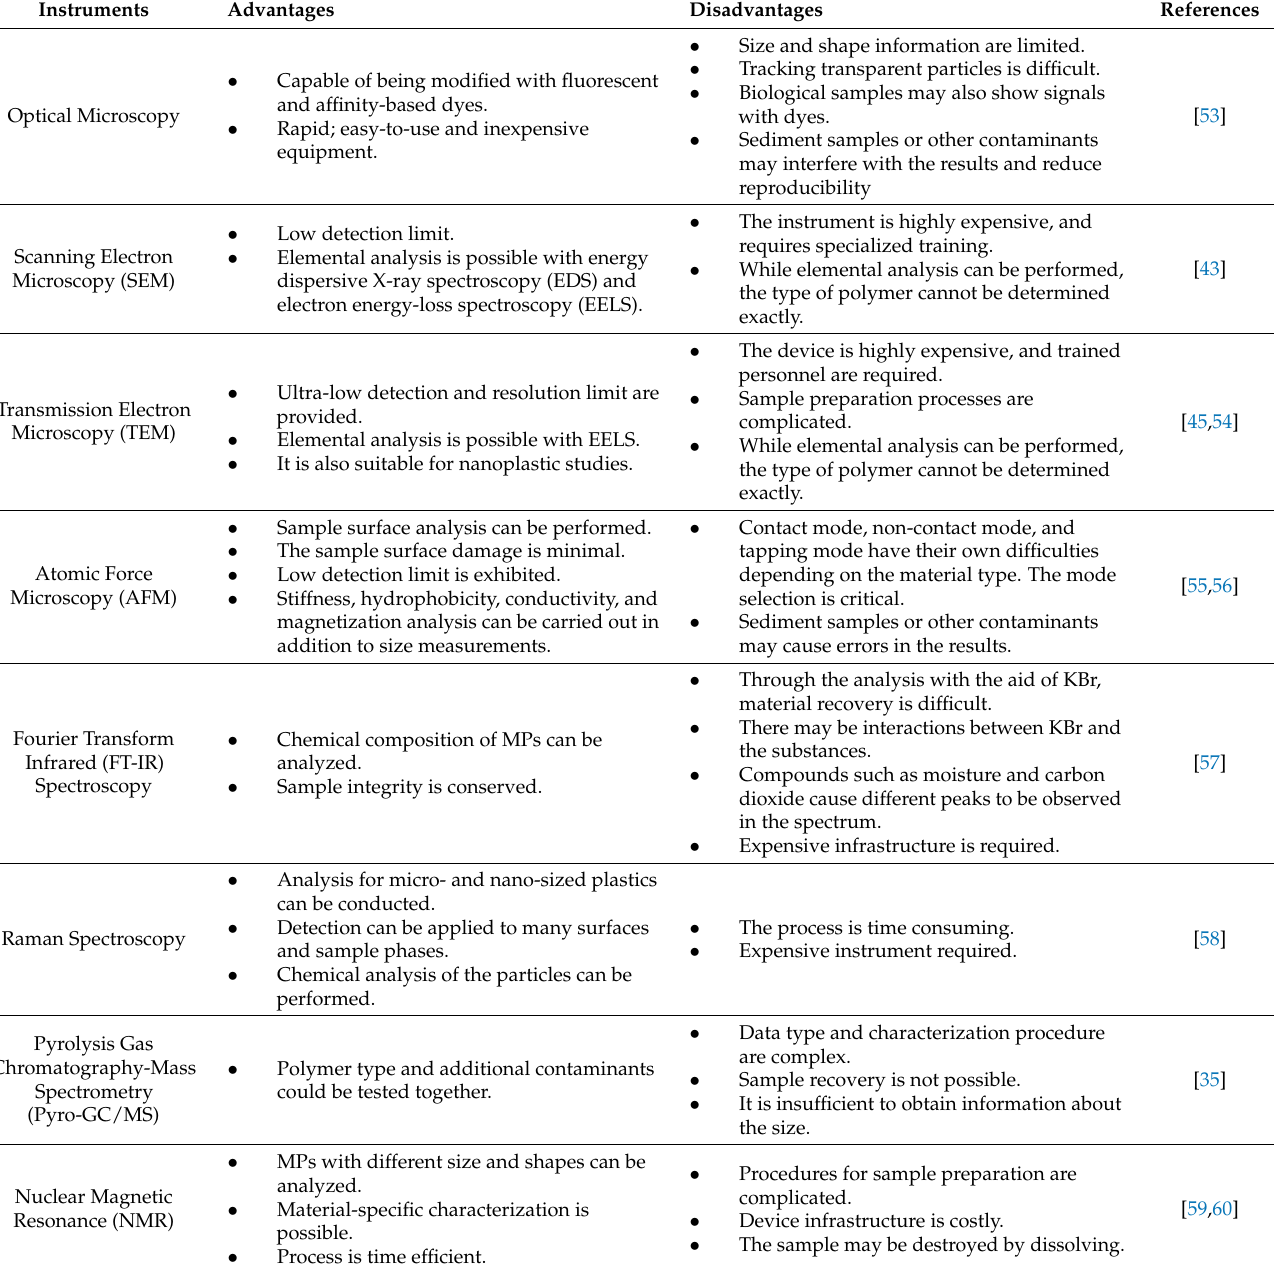
Table 1. Conventional detection and characterization methods for